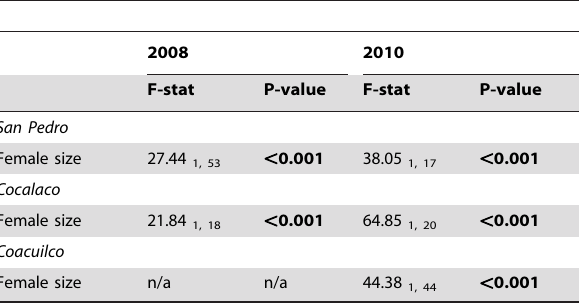
Table 2. Offspring number as a function of female size for each site in each